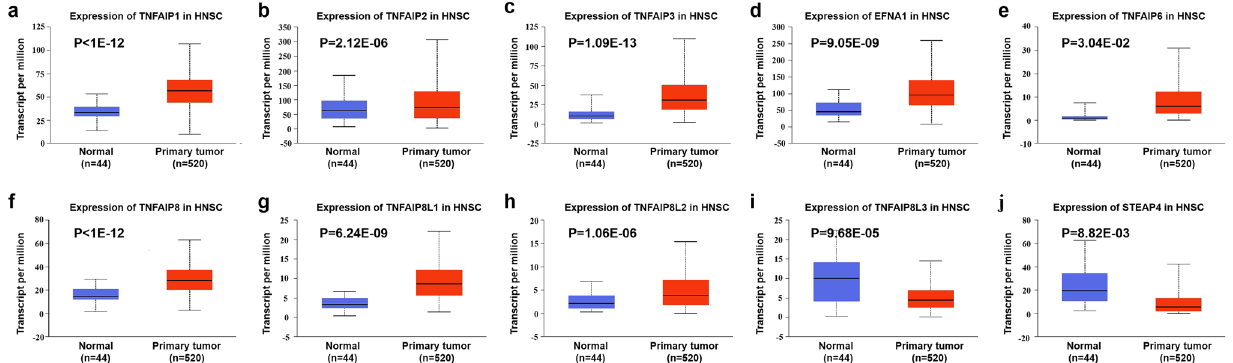
Figure 2. Comparison of the transcript level of TNFAIPs between HNC tissues and normal tissues. The transcript levels of ( a ) TNFAIP1, ( b ) TNFAIP2, ( c ) TNFAIP3, ( d ) EFNA1, ( e ) TNFAIP6, ( f ) TNFAIP8, ( g )